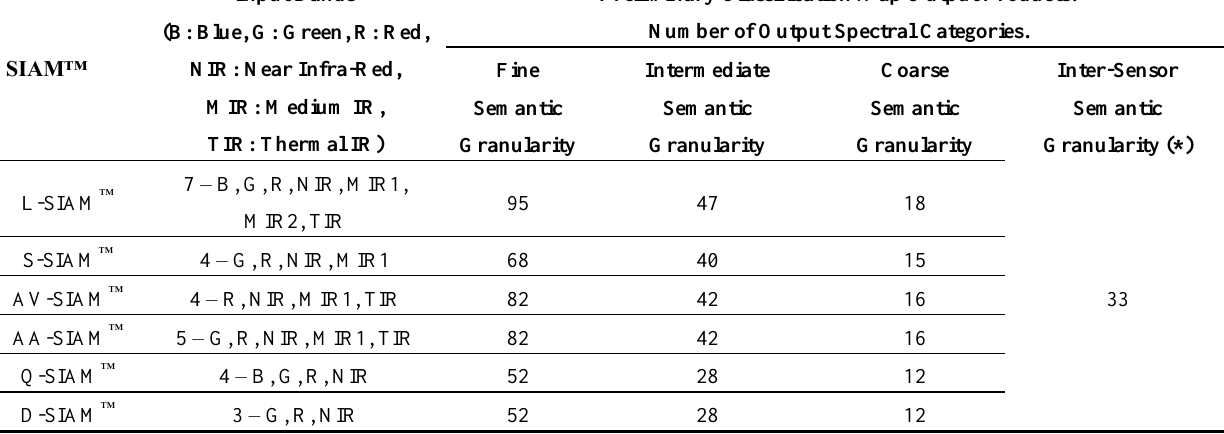
Table 4. SIAM™ system of systems. Summary of input bands and output spectral categories reported in Table 1. (*) Employed in sensor-independent bi-temporal land cover change